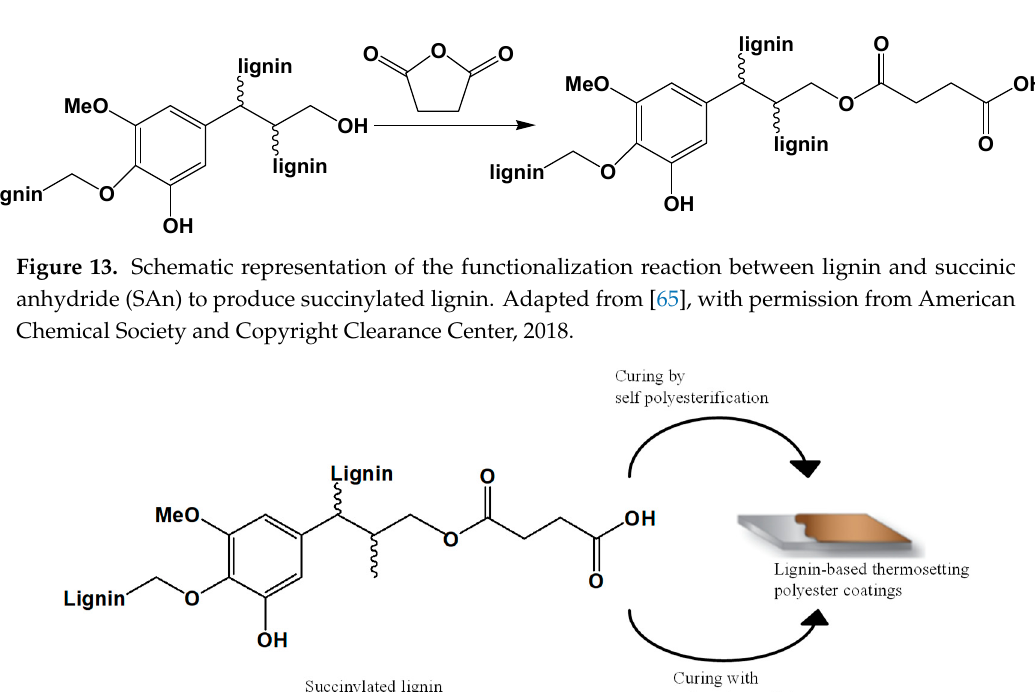
Figure 14. Process of curing the succinylated lignin in a substrate. Adapted from [65], with permission from American Chemical Society and Copyright Clearance Center, 2018.